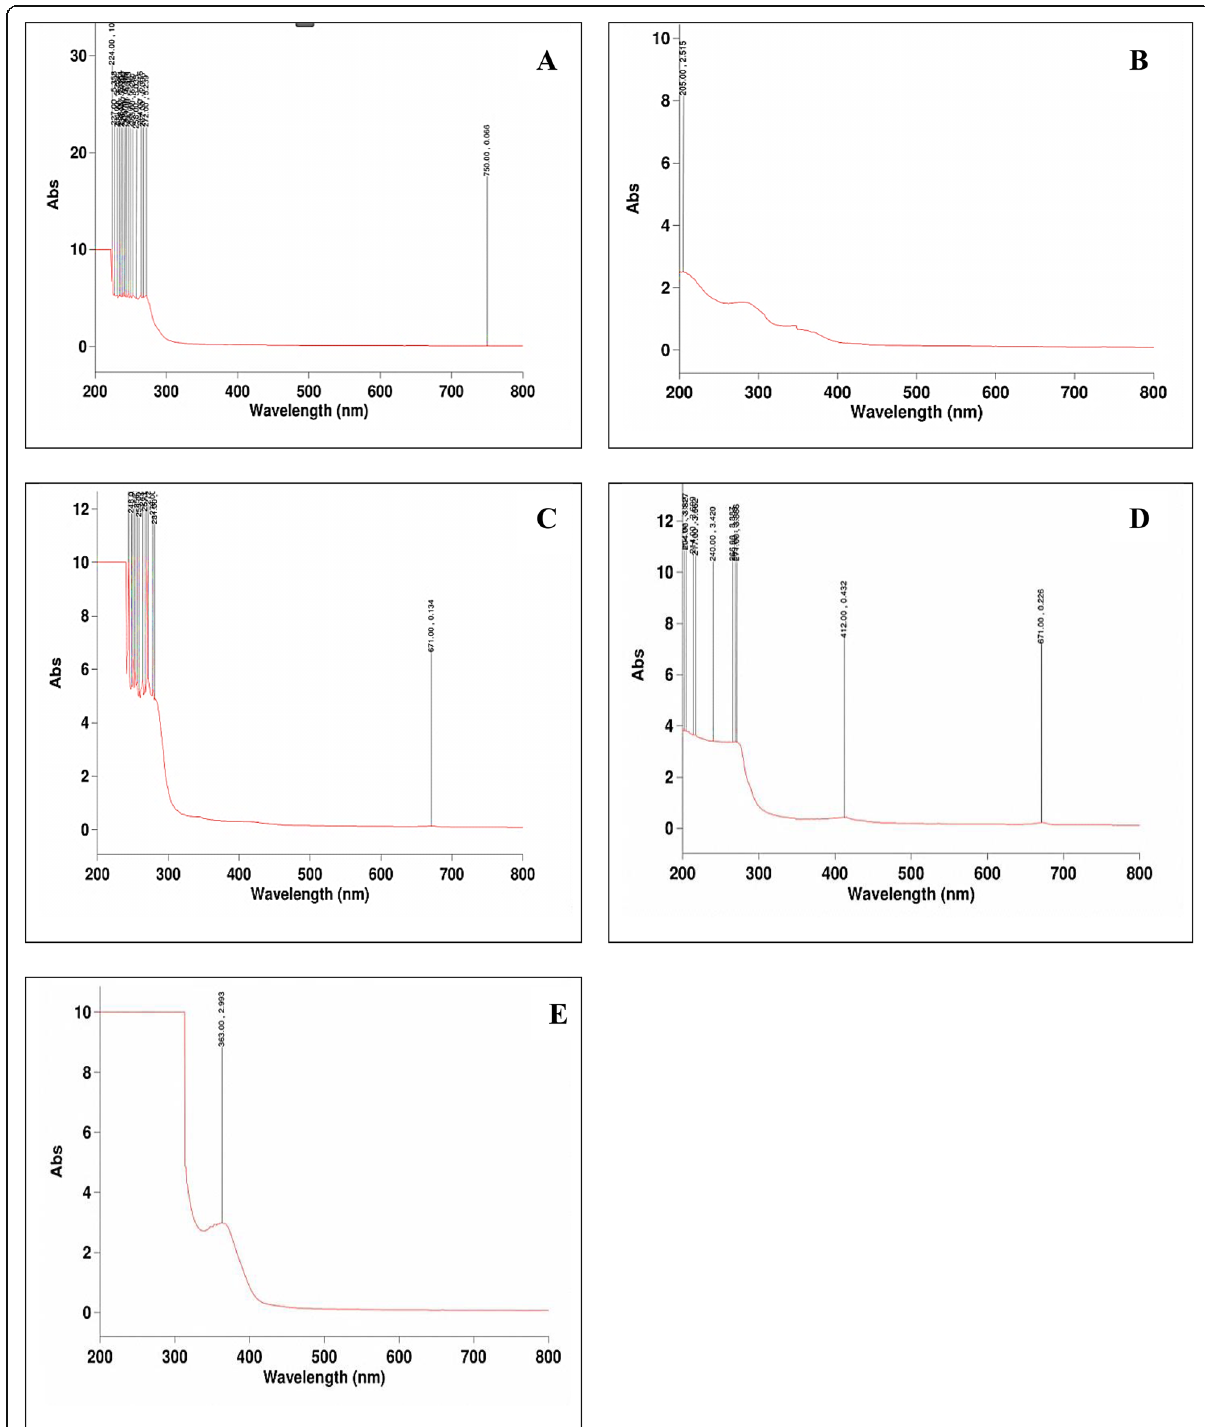
Fig. 6 UV-visible spectra of a Petroleum ether extract of A . occidentale . b Ethylacetate extract of A . occidentale . c n -hexane extract of P . guajava . d Petroleum ether extract of T. catappa . e Ethylacetate extract of T .